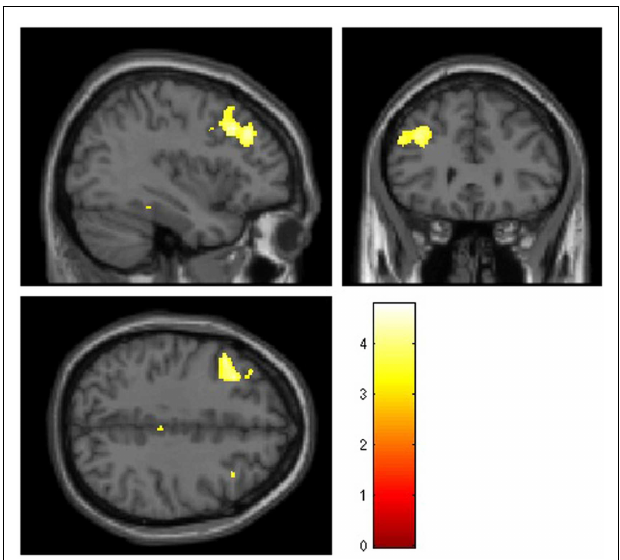
FIGURE 1 | Mean smaller gray matter volumes observed in 30 non-treatment-seeking cocaine-dependent individuals compared to 33 non-drug using controls in the left middle frontal gyrus using whole-brain voxel-based morphometry analysis . Significant clusters ( p < 0.05 corrected, at a height threshold of p < 0.001, uncorrected) are shown on an underlying Montreal Neurological Institute (MNI) template brain (left = left). Statistical tests between groups were performed using ANVOCA covariated for age in SPM8.The red/orange scale represents the corresponding T values.